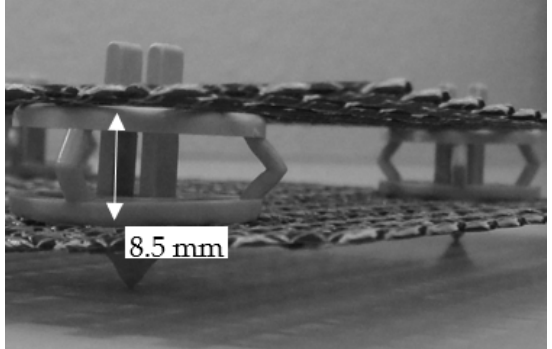
Figure 2. The spacer connections, inserted between two textile layers.